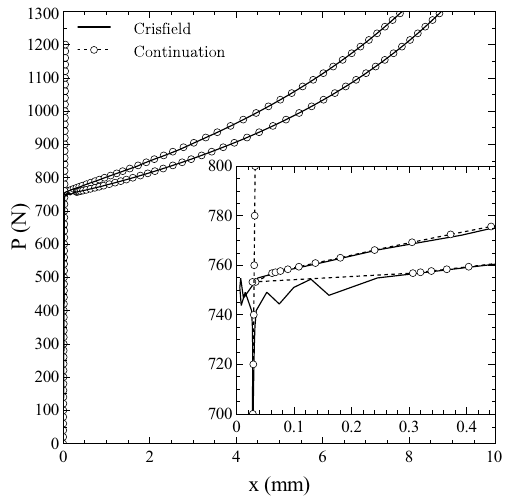
Figure 5. Bifurcation plot for axially compressed